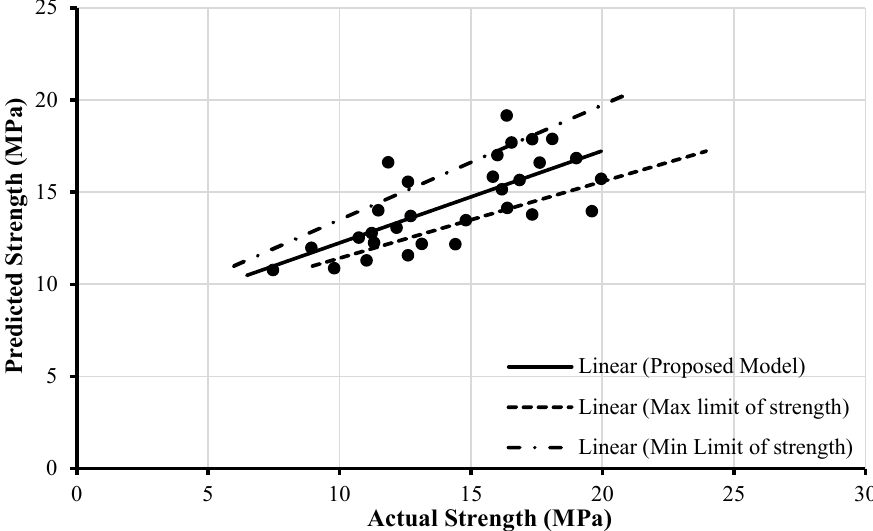
Figure 14. Actual vs. predicted equation strength.